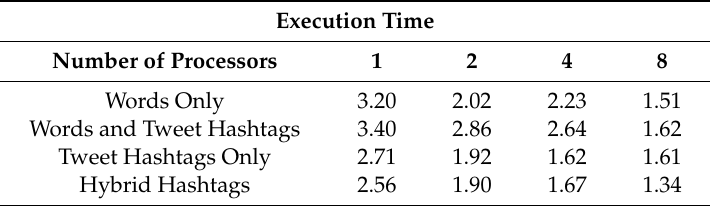
Table 9. Speed up for HHTC-Stream (in seconds) with different numbers of nodes for different sets of features.